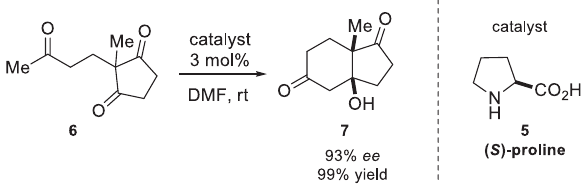
Figure 3 . Asymmetric aldol reaction catalysed by ( S )-proline, see Ref. [25].